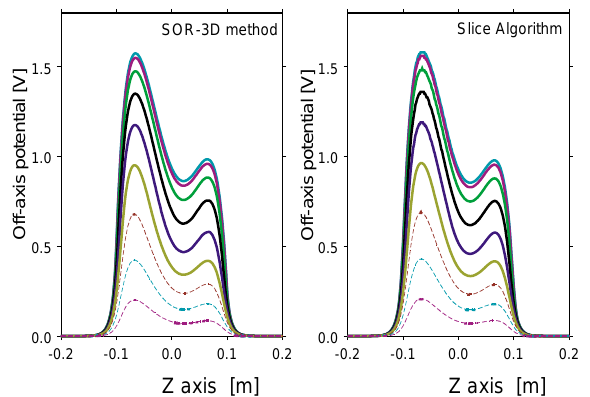
FIG. 3. (Color) The space charge potential u (cid:1) r , z (cid:2) as a function of z for different radii for the bunch of Fig. 1 inside a conducting pipe of radius 2 cm calculated using the SOR-3D method (left) and the slice algorithm (right).